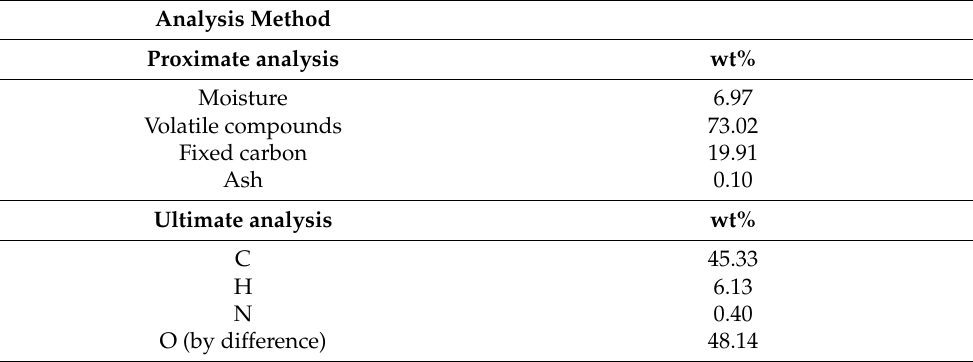
Table 1. Proximate and ultimate analyses of bamboo used in this work.